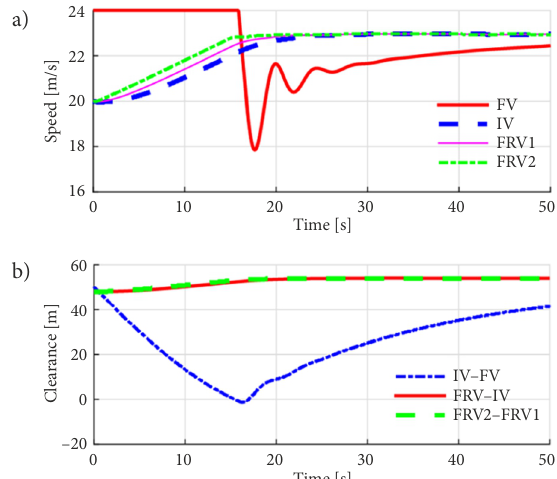
Figure 14. Speeds and clearance of vehicles without considering rear-end collision escape (source: created by the authors): a – speeds of vehicles; b – clearances between vehicles; FV – following vehicle; IV – intelligent vehicle; FRV – frontal